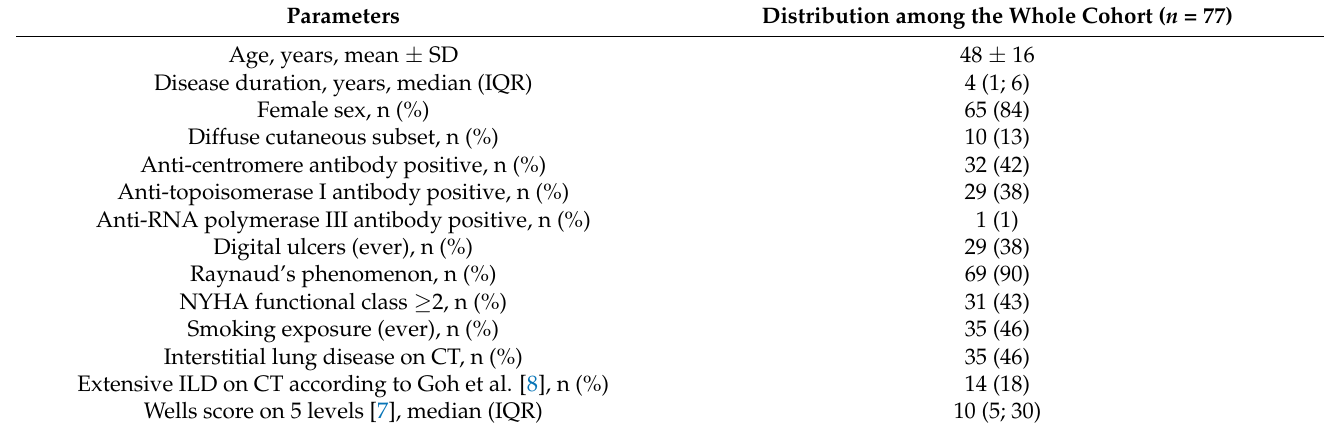
Table 1. Characteristics of the study population.